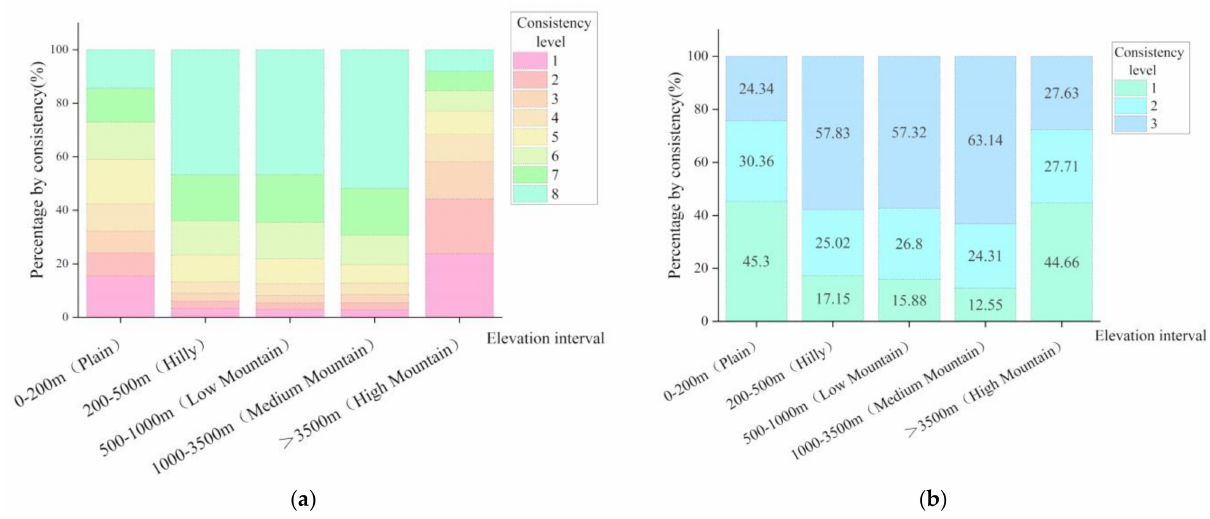
Figure 8. Consistency distribution among different elevation intervals. ( a ) Eight datasets; ( b ) Three datasets in